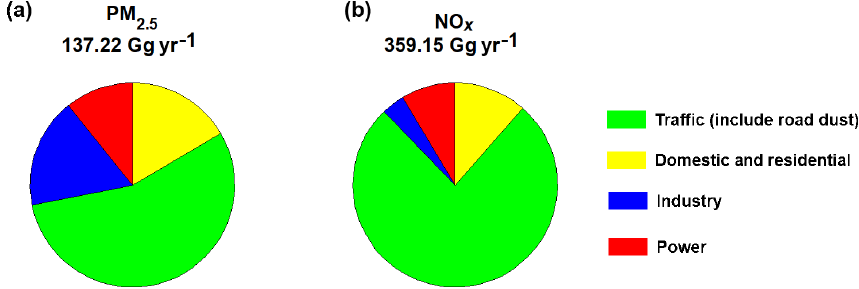
Figure 6. Annual emission of different sectors in Delhi from SAFAR inventory. (a) PM 2 . 5 ; (b) NO x . The emissions of black carbon, organic carbon, non-methane VOC (NMVOC) and SO 2 are given in Fig.